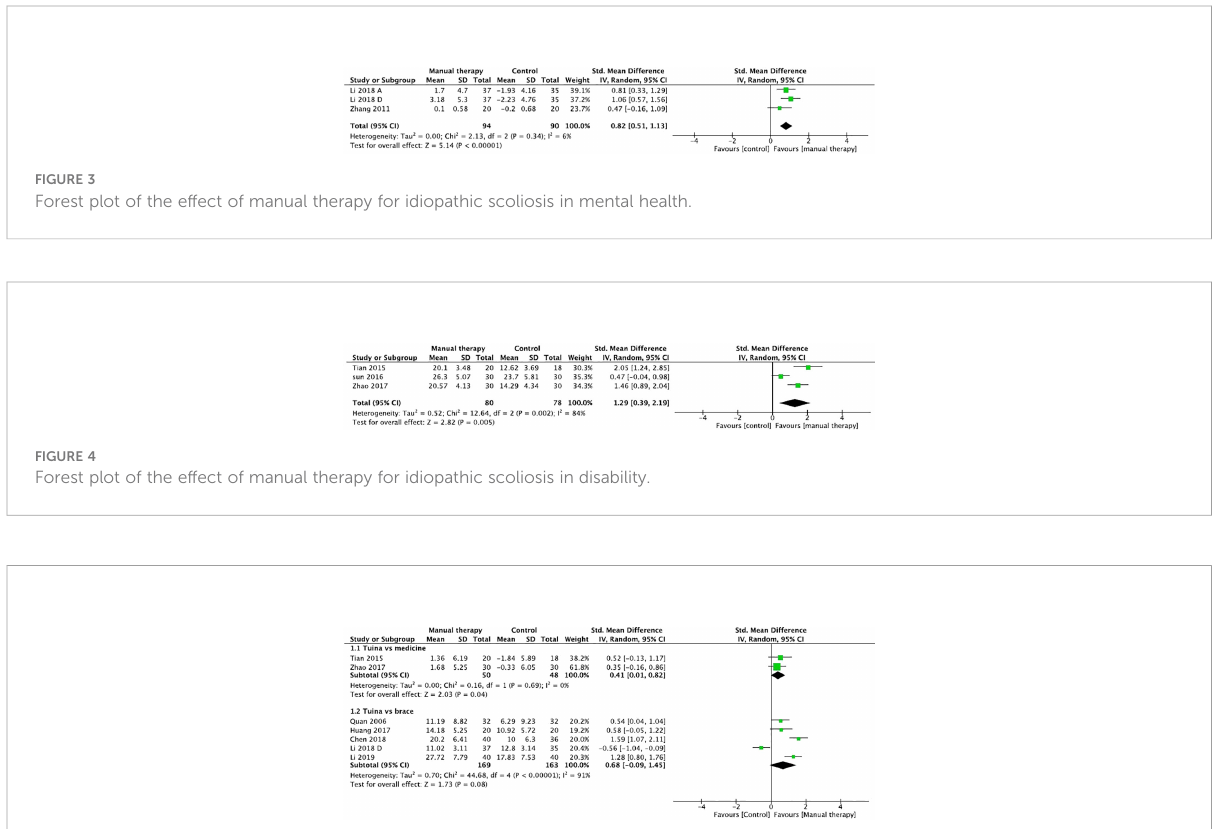
FIGURE 5 Forest plot of the effect of manual therapy for idiopathic scoliosis in Cobb angles.